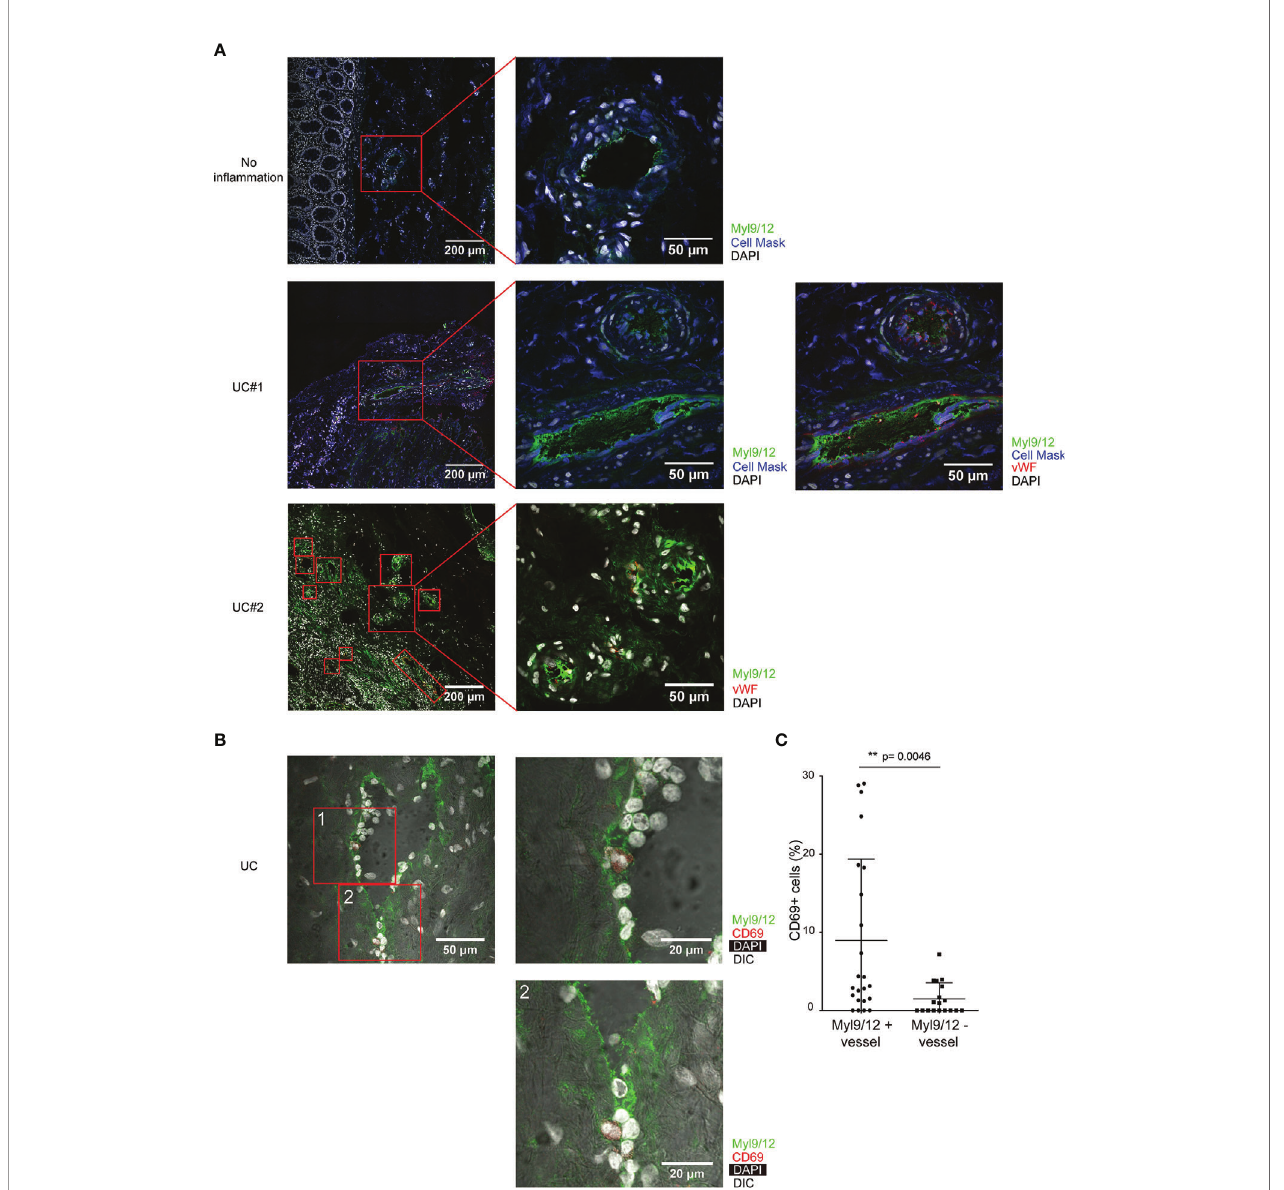
FIGURE 3 | The high expression of Myl9/12 in the in fl amed colon in UC patients. (A) Immunohistological analyses of in fl amed colon specimens of UC patients and non-in fl amed colon specimens of colon cancer patients, stained as indicated (UC, n = 3; No in fl ammation, n = 3). Red squares indicate blood vessels, which are visualized by vWF staining (×400). (B) Immunohistological analyses of the in fl amed colon of UC patients, stained as indicated. Red squares indicate blood vessels (×400). (C) The frequency of CD69-expressing cells close to Myl9/12-positive vessels versus Myl9/12-negative vessels in the in fl amed colon. A total of 23 fi elds where Myl9/12-postive vessels were located in the center and 18 fi elds where Myl9/12-negative vessels were located in the center were examined using colon samples from fi ve patients. **p <